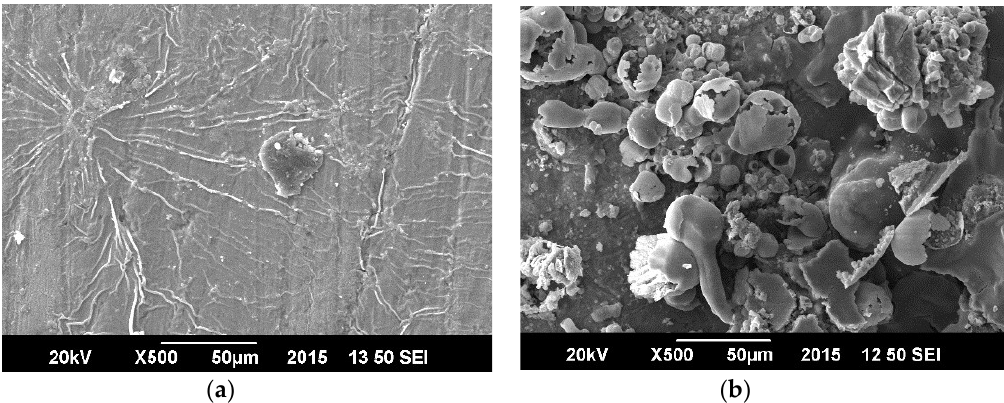
Figure 11. SEM image-ZnO/GO coated sample (produced water of crude oil) ( a ) Before corrosion test ( b ) After corrosion test.